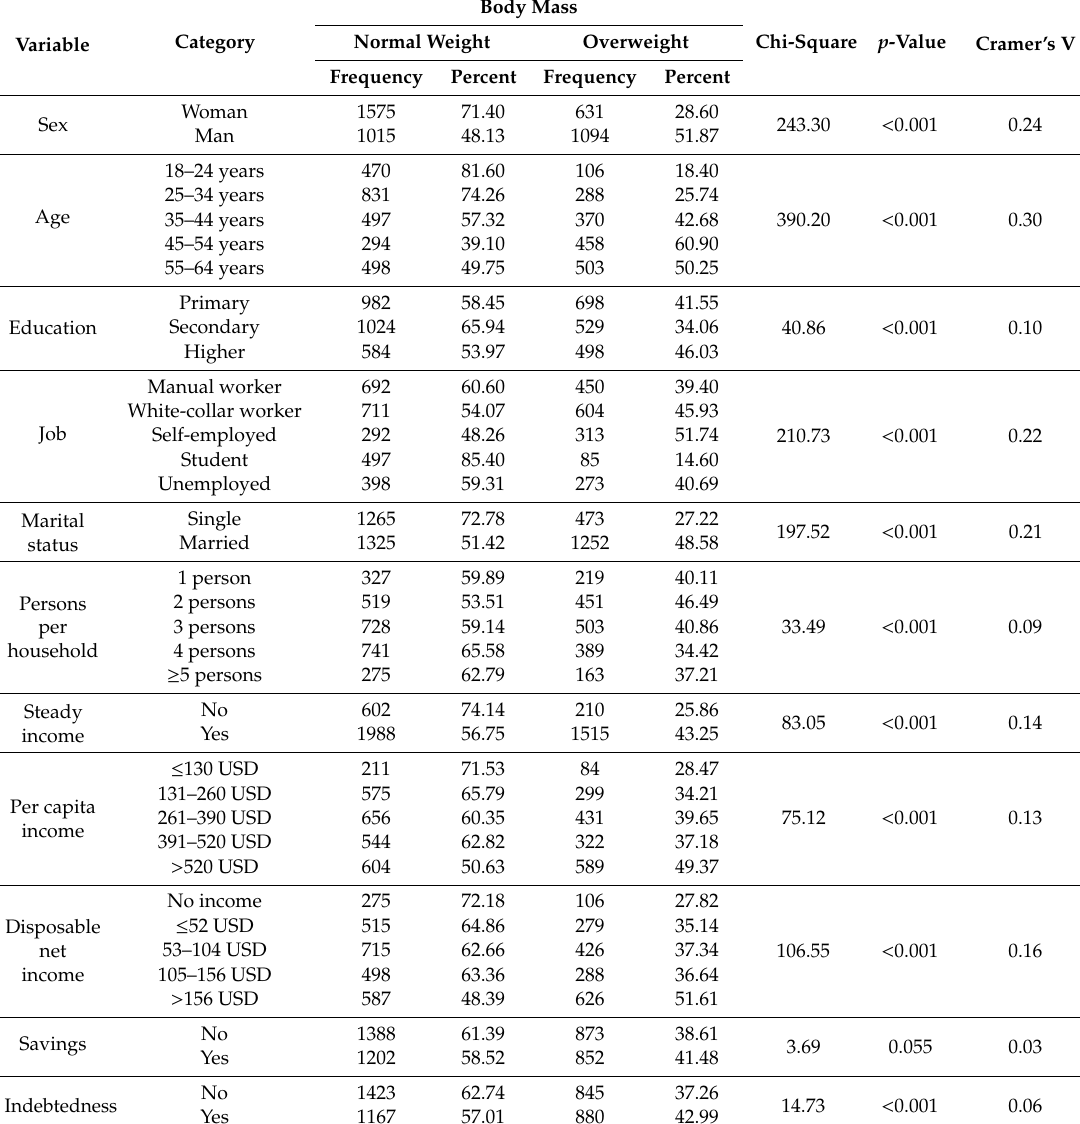
Table 3. Body mass and selected demographic and socioeconomic characteristics of Wrocław residents ( n =